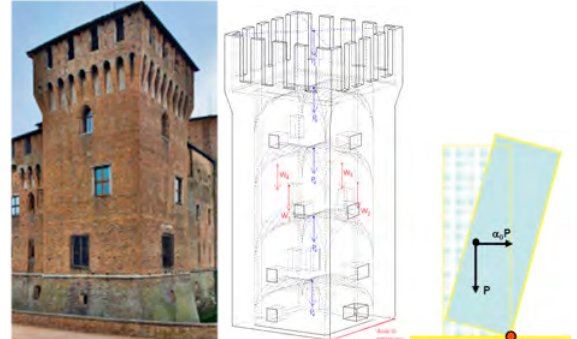
Figure 6. (a)The North-East tower; (b) The loads involved in the local mechanism; (c) the scheme of the local mechanism